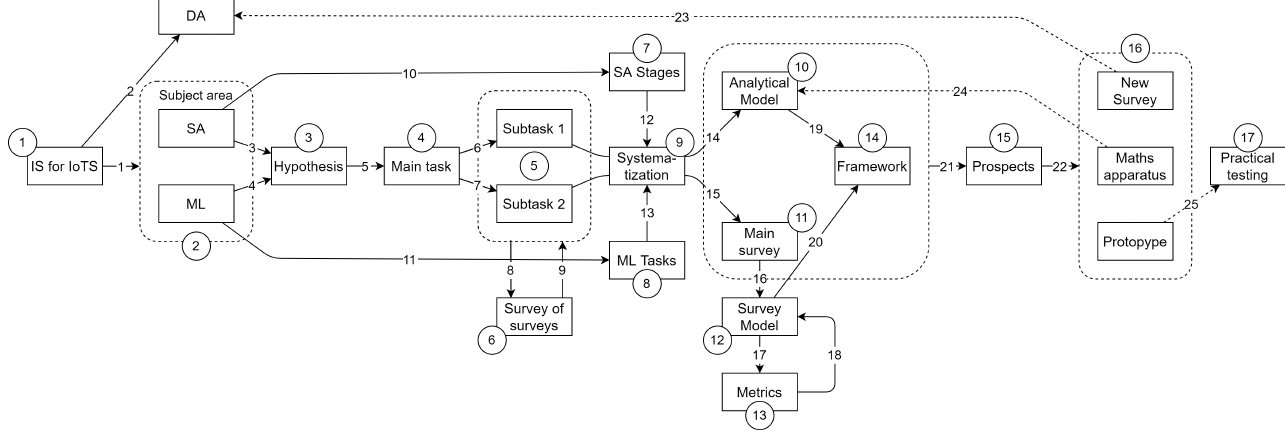
Carrying out practical experiments with the framework prototype and its analysis.